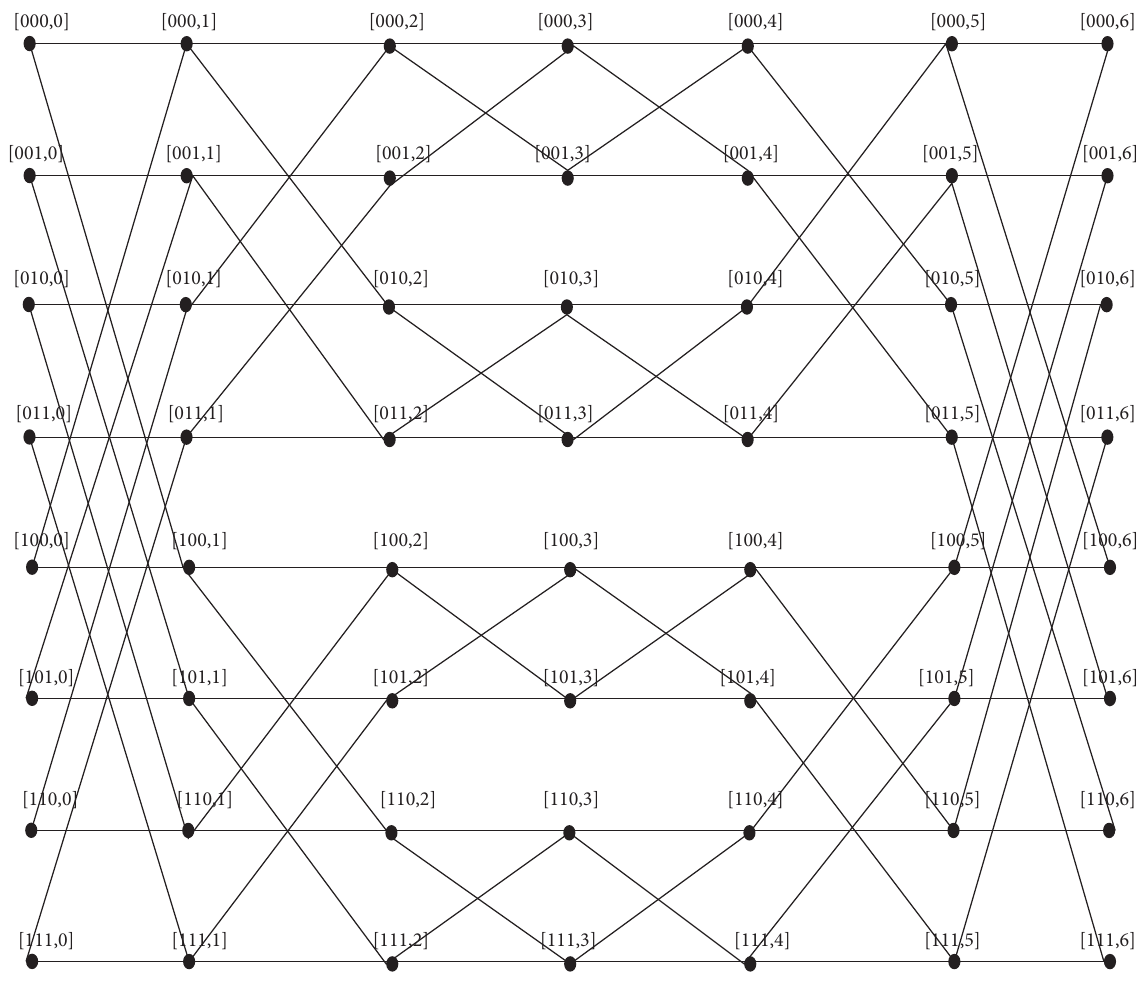
Figure 5: Normal representation of B